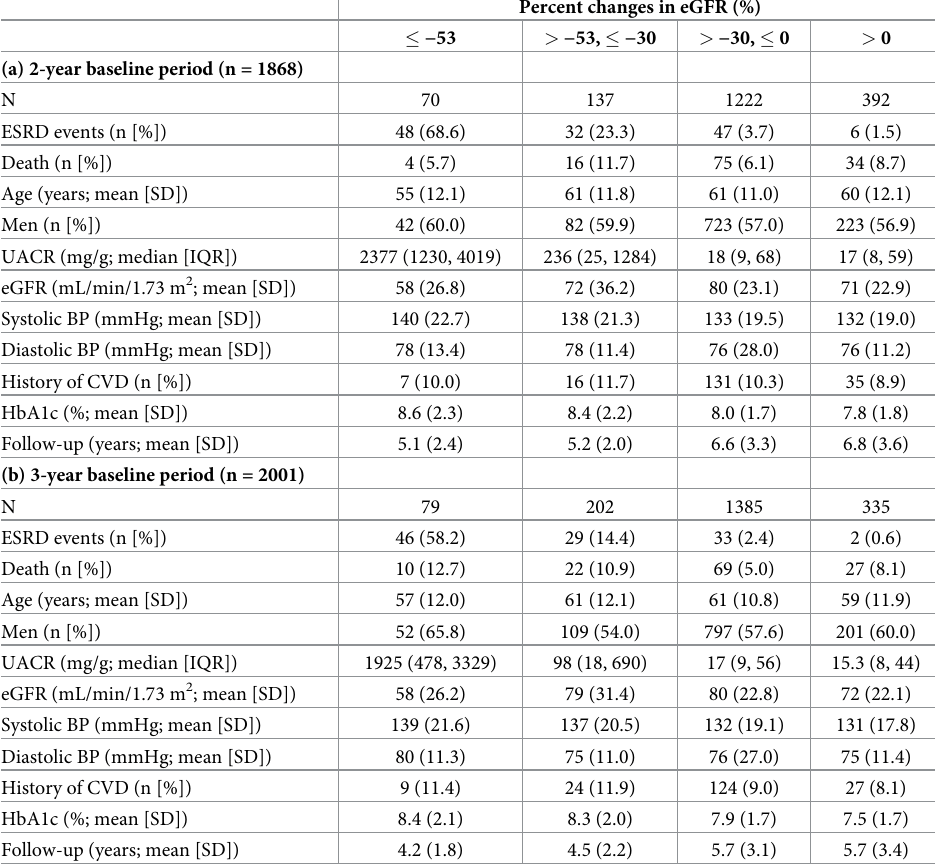
Percent changes in eGFR